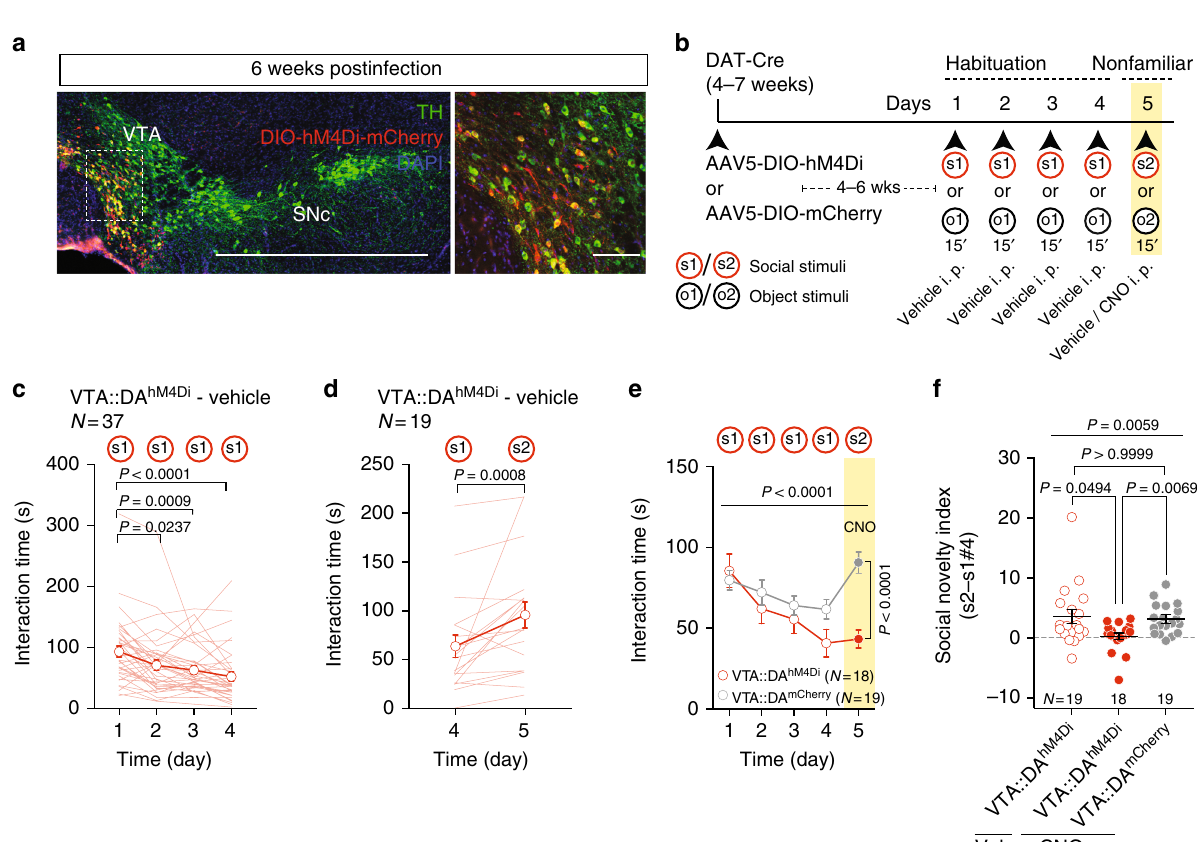
(Supplementary Fig. 2a, d), VTA::DA mCherry mice treated with CNO (Supplementary Fig. 2b, e) as well as VTA::DA hM4Di mice treated with CNO (Supplementary Fig. 2c, f) exhibited sociability.